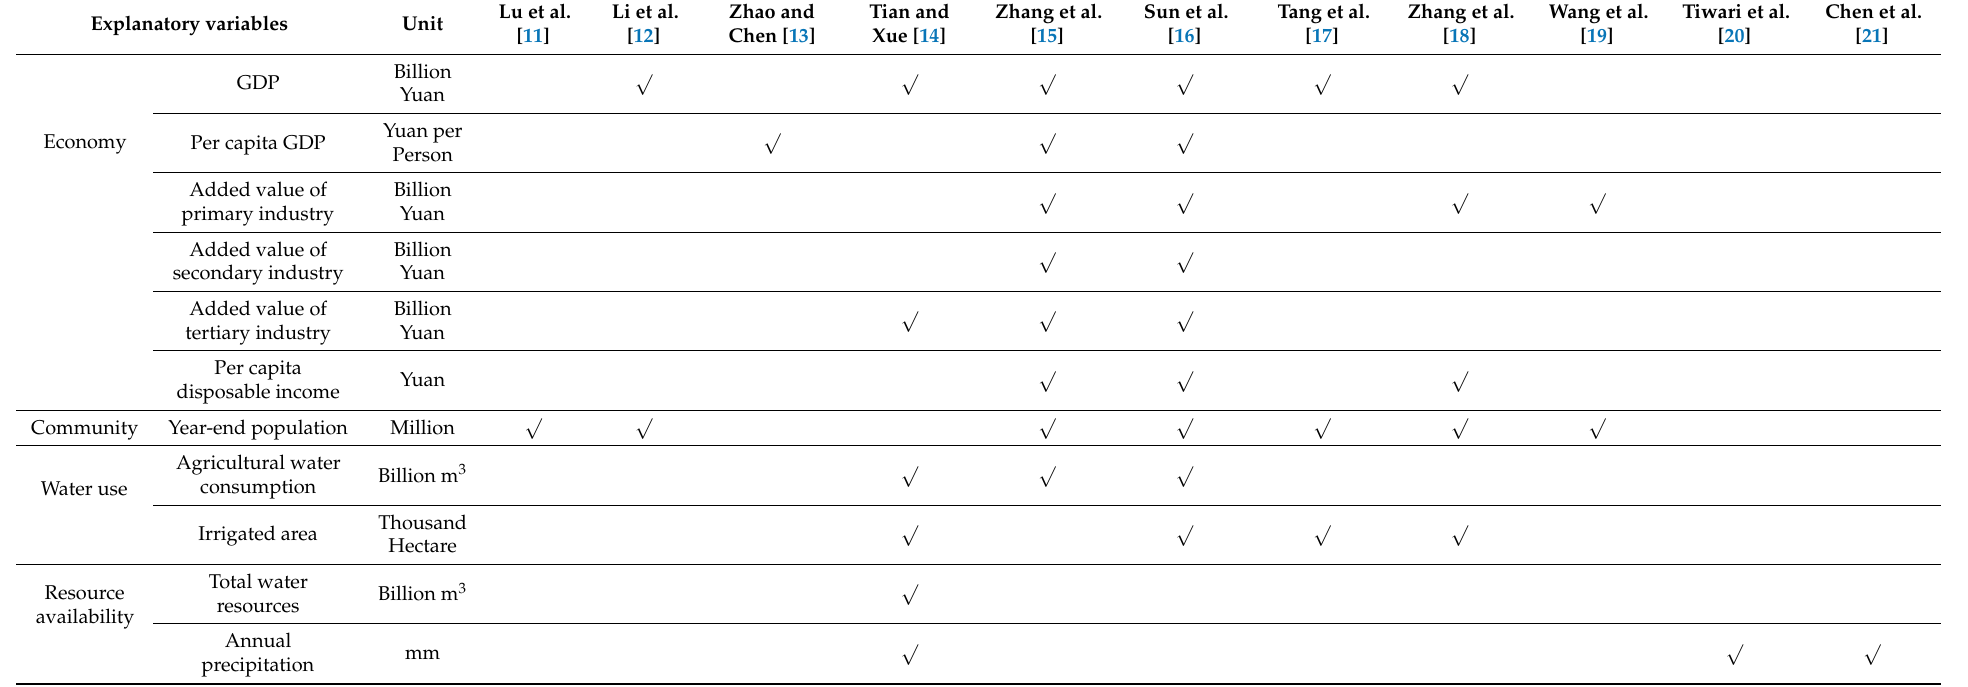
Table 1. Main explanatory variables found by other studies to affect water